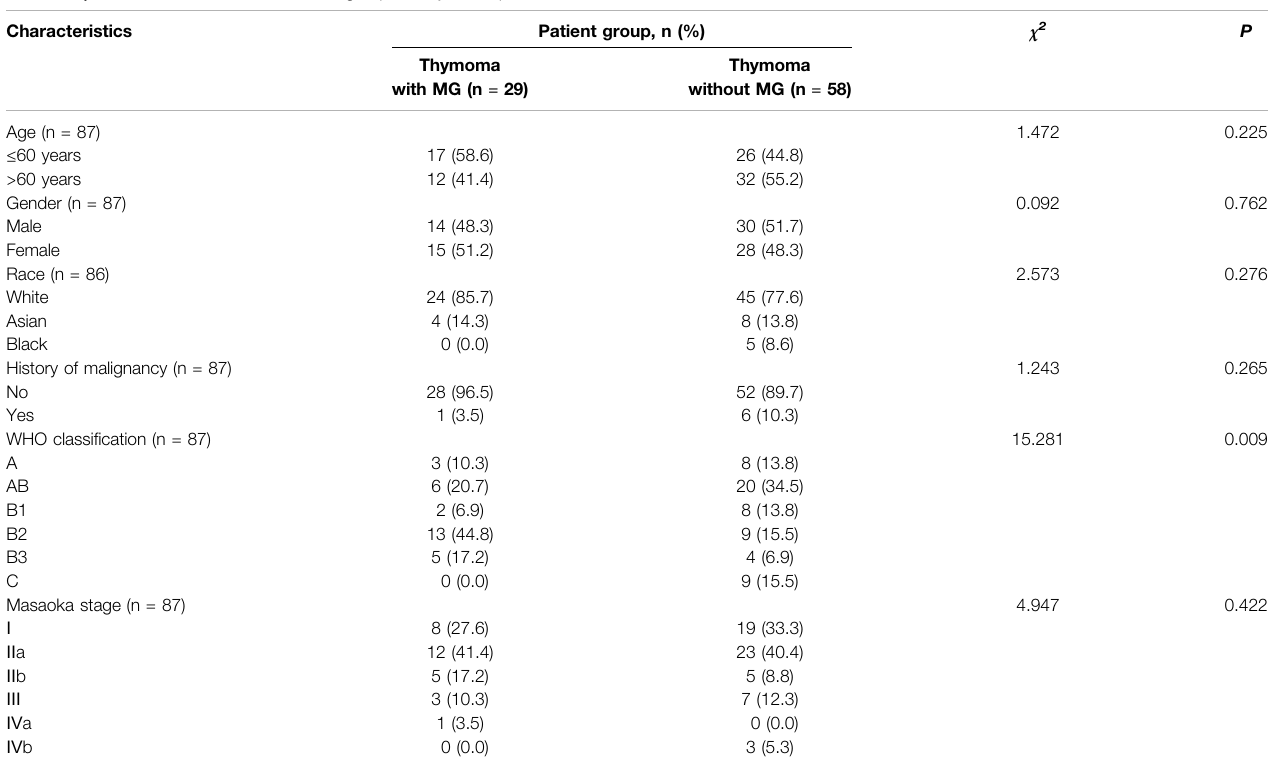
TABLE 1 | Patient characteristics of the two groups of thymoma patients.